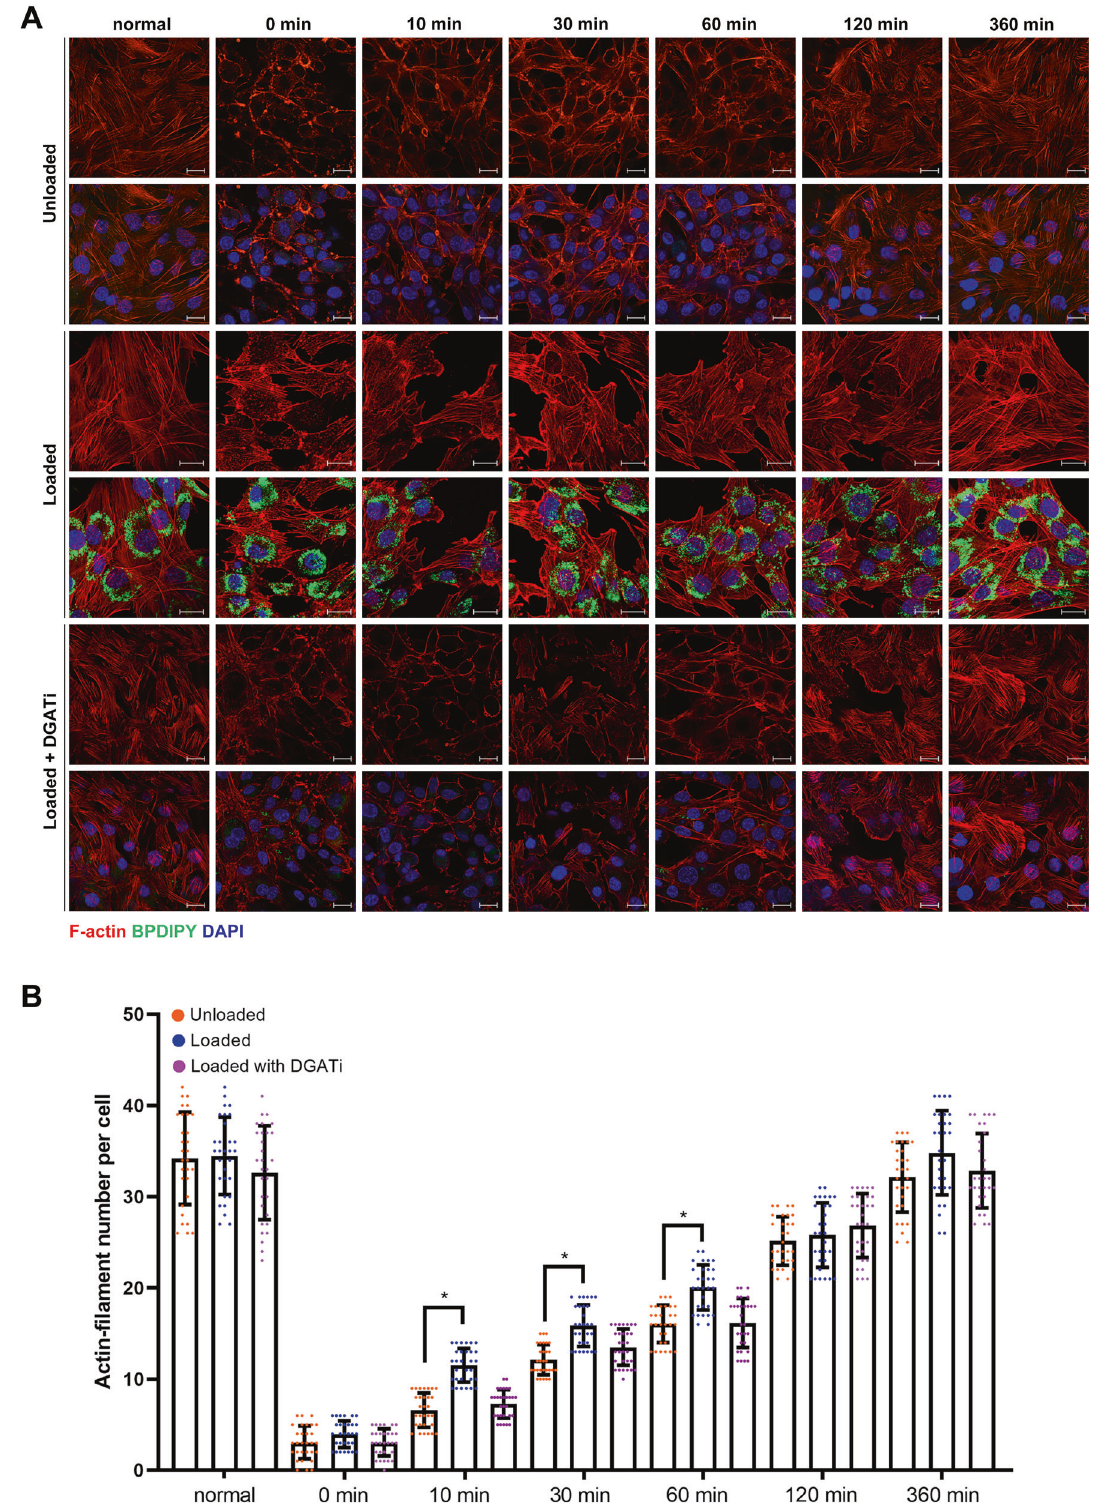
Fig. 3 LDs accelerate micro fi lament remodeling. A The rate of actin- fi lament remodeling. C2C12 cells were pre-treated with 400 μ M of oleic acid (OA, named loaded cells) or 3% bovine serum albumin (BSA, control, named unloaded cells). For DGATi treatment, the inhibitor of DGAT1 and DGAT2 was added into medium for 12 h before OA treatment, bar, 20 μ m. B The count of micro fi lament number per cell. * p < 0.05. Results are from three technical repeats ( N = 3) for a representative of three biological repeats ( N =